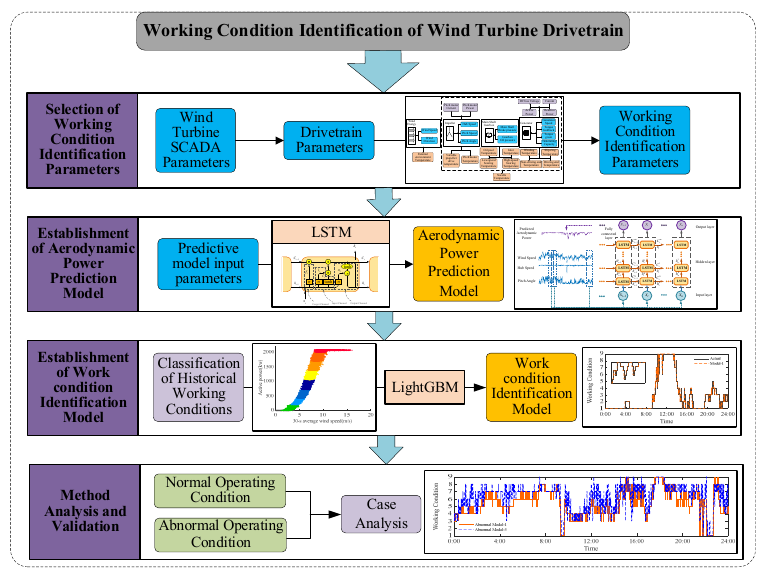
Figure 1. The overall fl owchart.